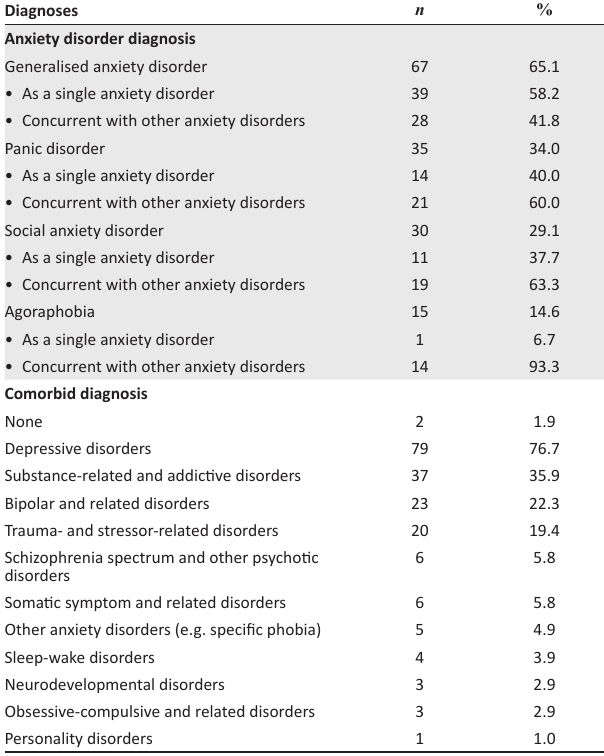
TABLE 2: Diagnostic morbidity and psychiatric comorbidity of anxiety disorders.